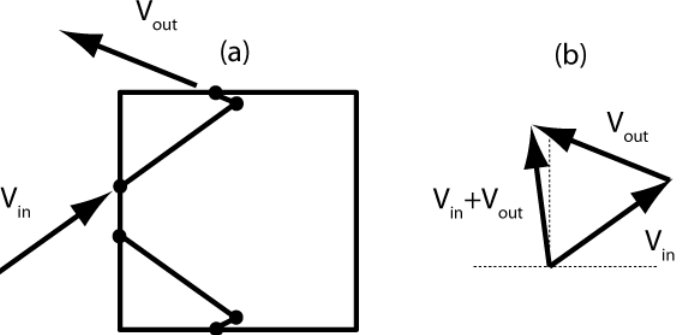
Table 6. Hydraulic conductivity tensors computed on the networks displayed in Figure 24.